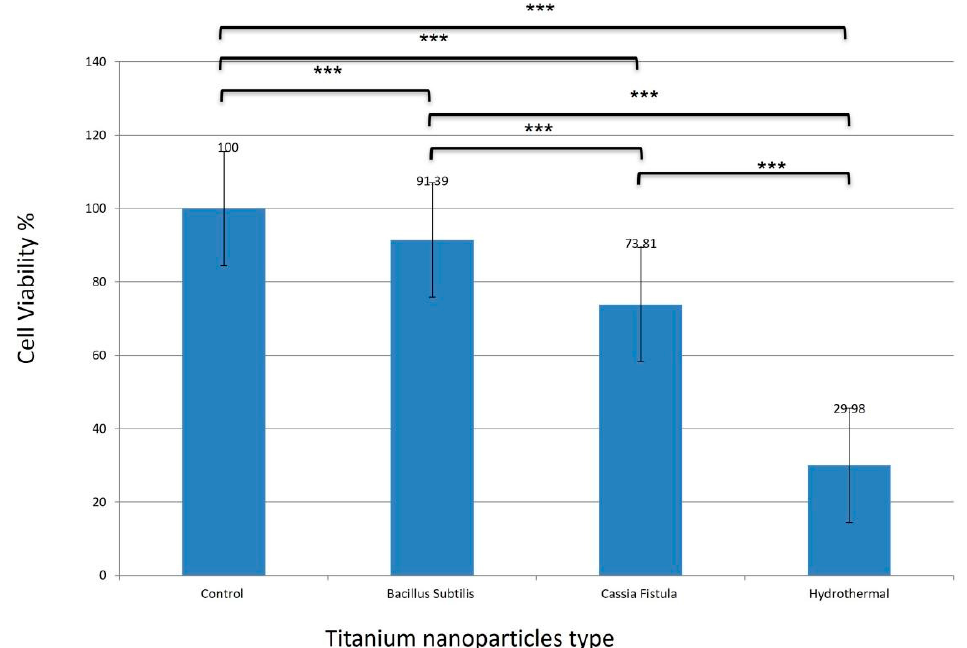
Figure 13. Cell Viability (%) of titanium nanoparticles formed by Bacillus subtilis , Cassia fistula and titanium tetrachloride at 41st day in comparison to control group (*** p < 0.001, error bars = S.E).